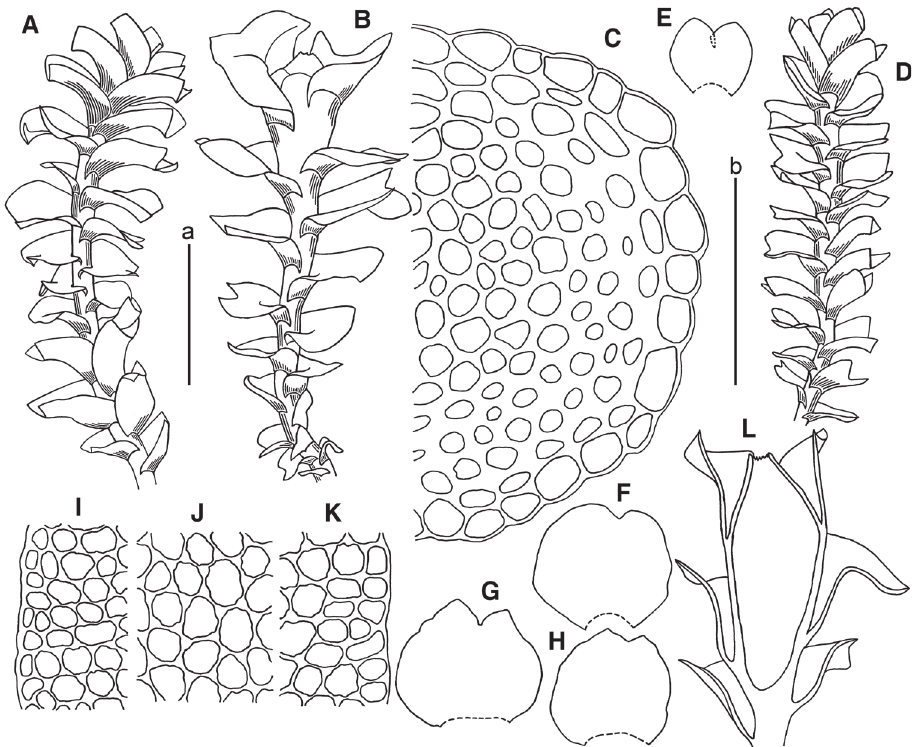
Figure 2. Marsupella apertifolia Steph. A male plant B female plants C stem cross section (fragment) D plant habit E–H leaves I, K cells along leaf margin J midleaf cells L gynoecium longitudinal section. Scale bars: a 1 mm ( A, B, D–H, L ); b 100 μm ( C, I–K ). All from Choi 7383 (JNU). Drawing by S.J.